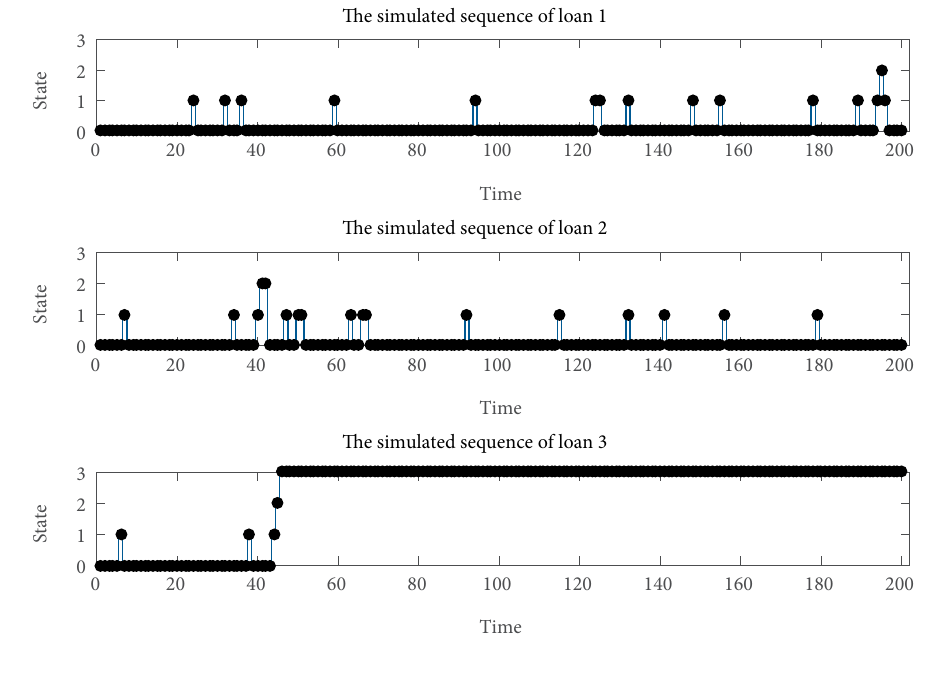
Figure 6: Simulated repayment state sequences of three randomly selected loans.